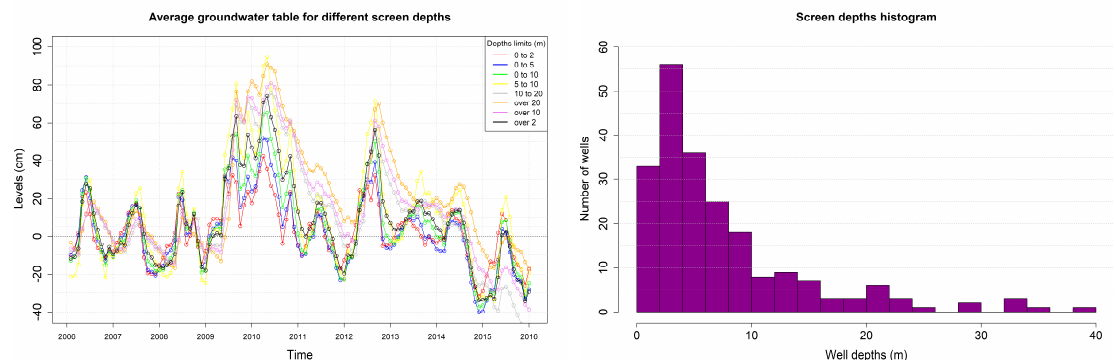
Figure 4. Average groundwater head for 6 different classes of screen depth ( a ) and number of wells with different depths ( b ).